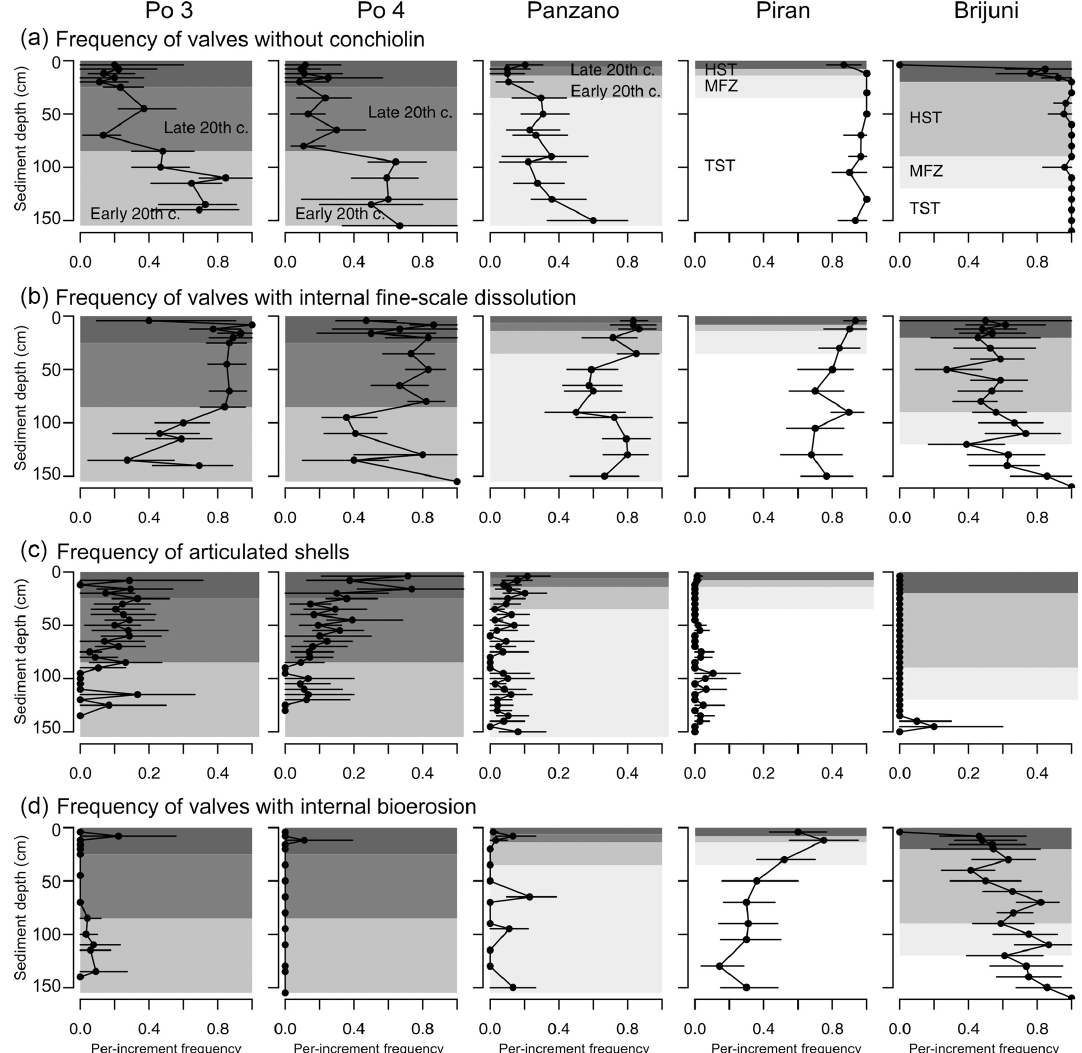
Figure 14. Stratigraphic changes in the per-increment frequency of valves of Varicorbula gibba affected by the loss of conchiolin ( a , external periostracum and internal conchiolin), by internal surficial fine-scale dissolution (b) , characterized by the presence of articulation (c) , and affected by internal bioerosion (d) . TST – transgressive system tract; MFZ – maximum flooding zone; HST – highstand system